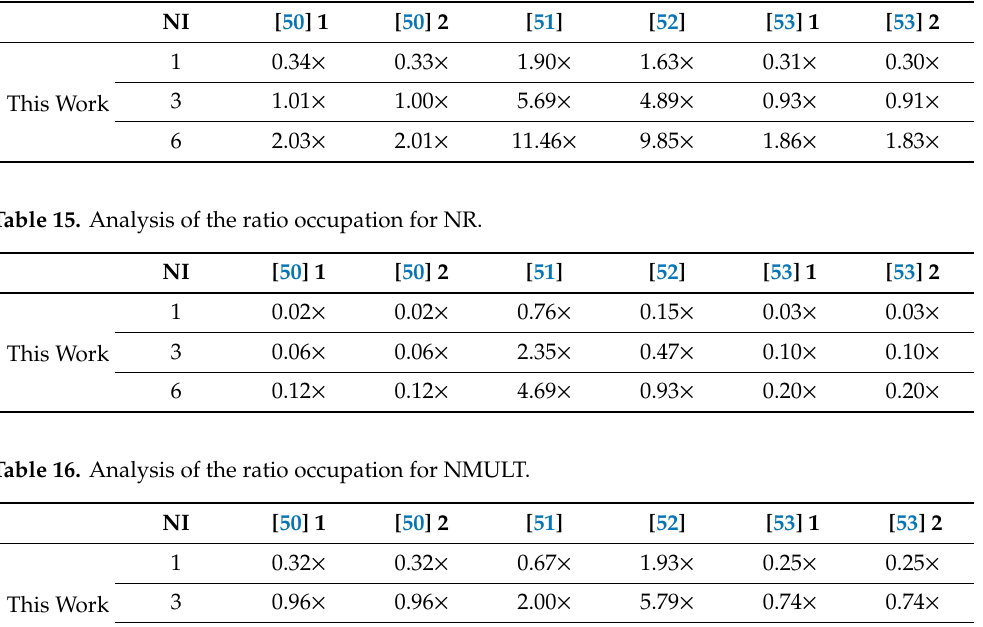
Table 14. Analysis of the ratio occupation for NLUT.